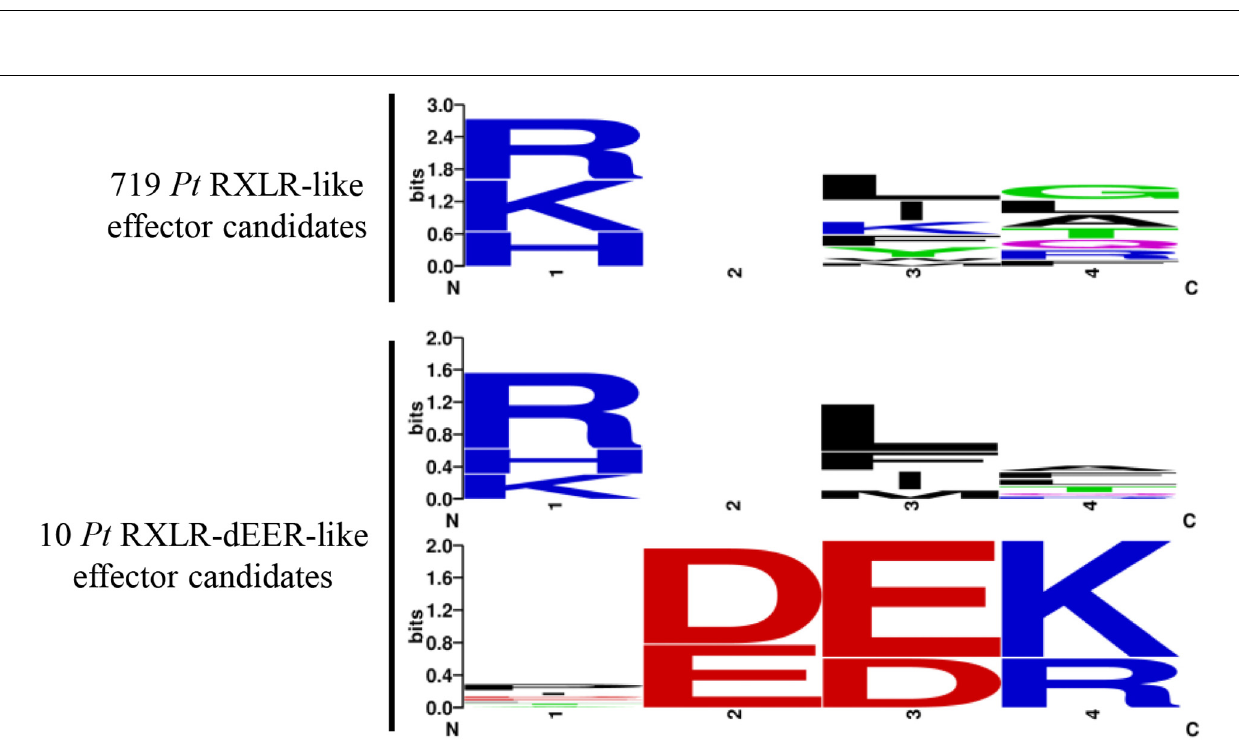
Frontiers in Microbiology |